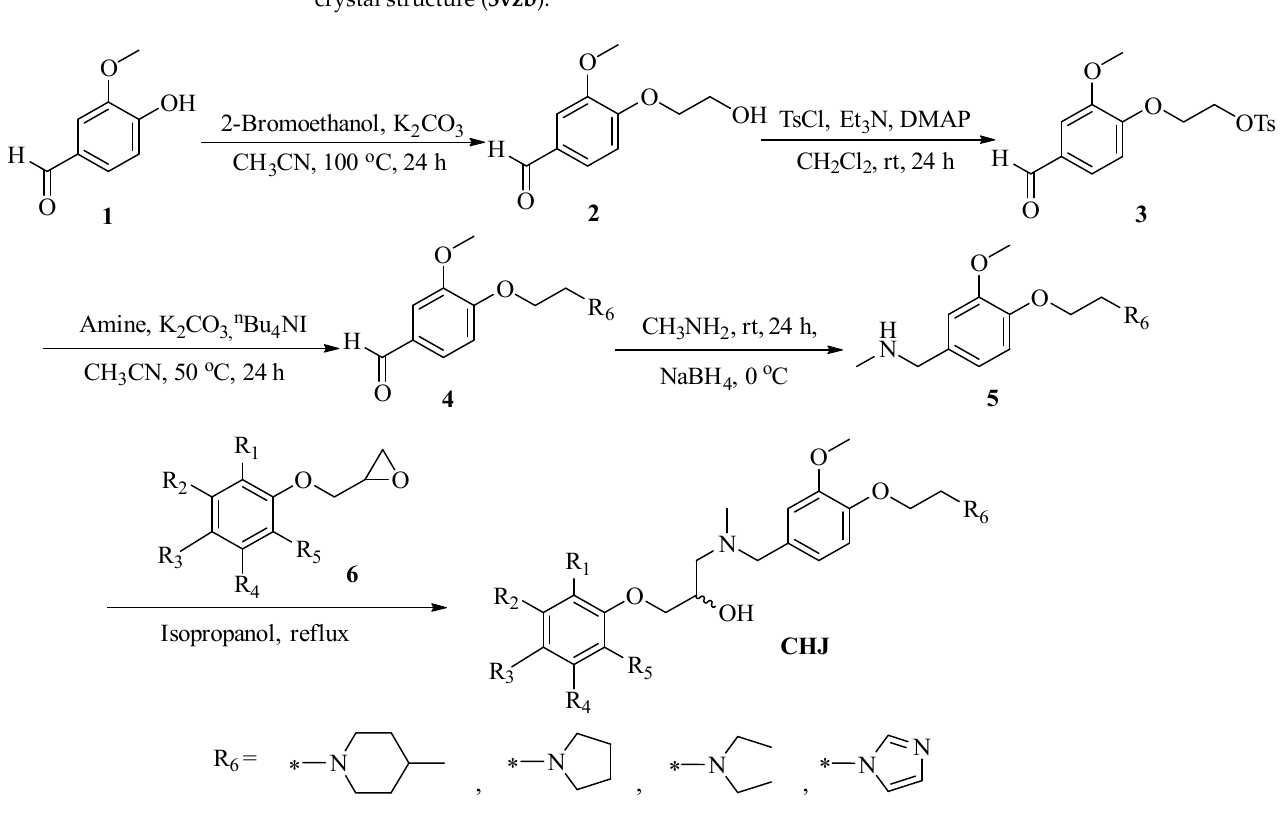
Scheme 1. The structures and synthetic route of designed compounds.